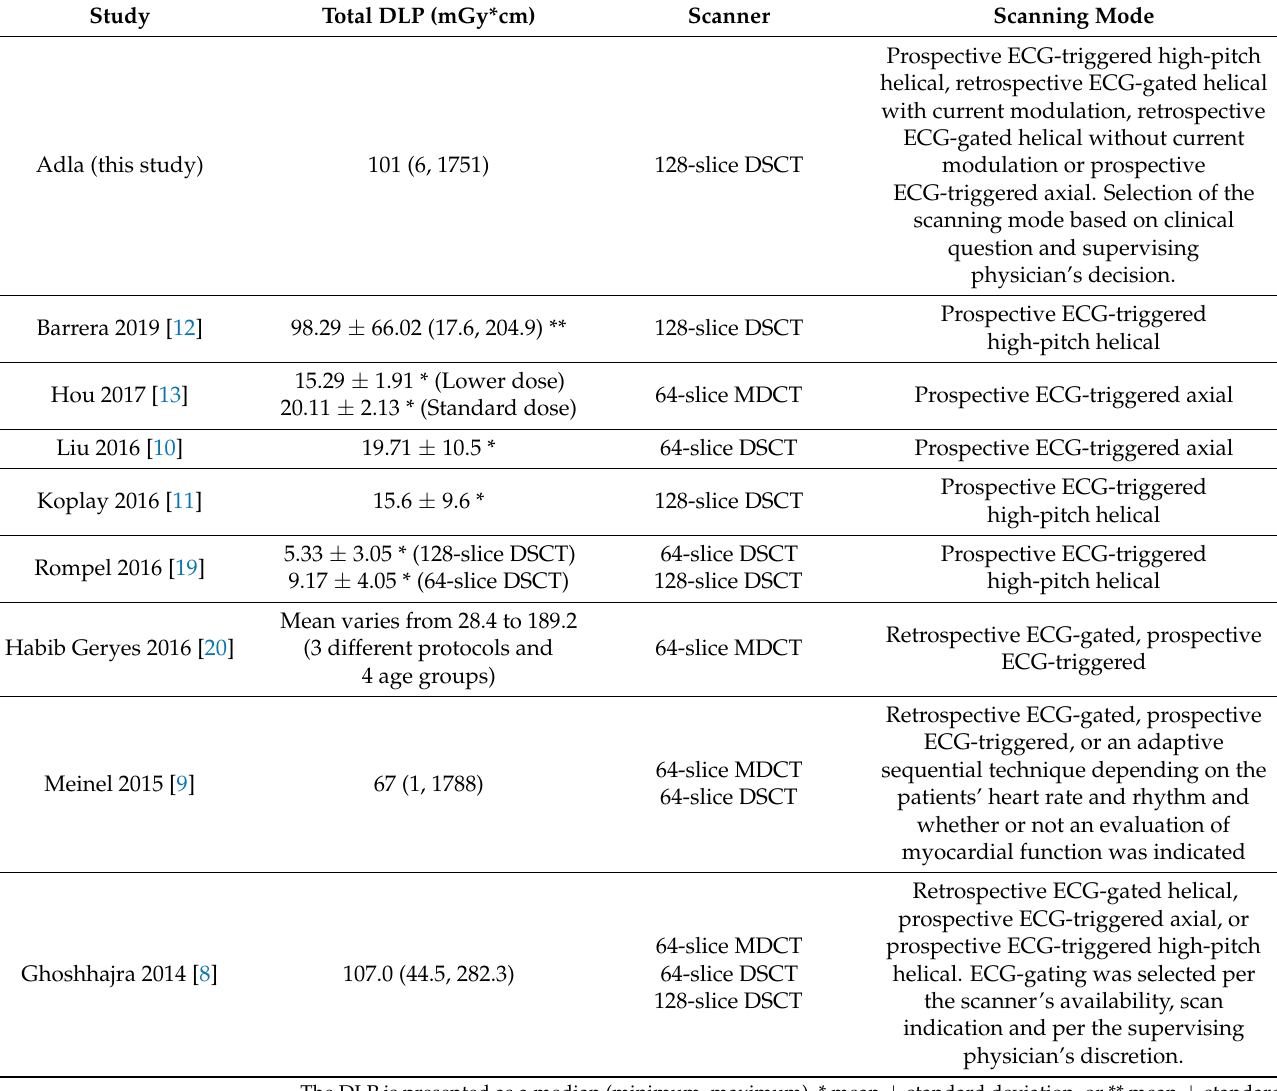
Table 6. Comparison of total DLP, scanners and scanning protocols with other